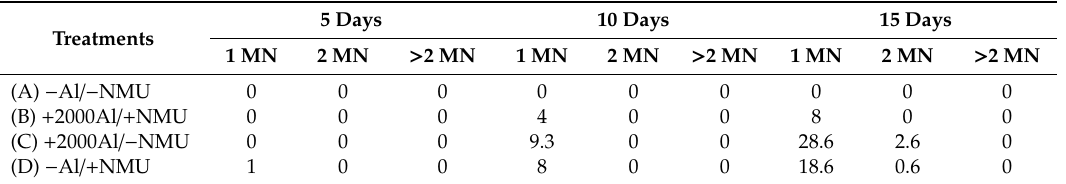
Table 2. Genotoxicity caused by experimental treatments by micronucleus count (MN) in